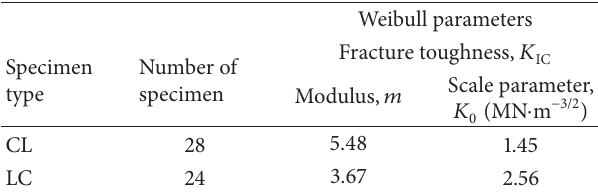
Table 3: Statistical parameters of fracture toughness